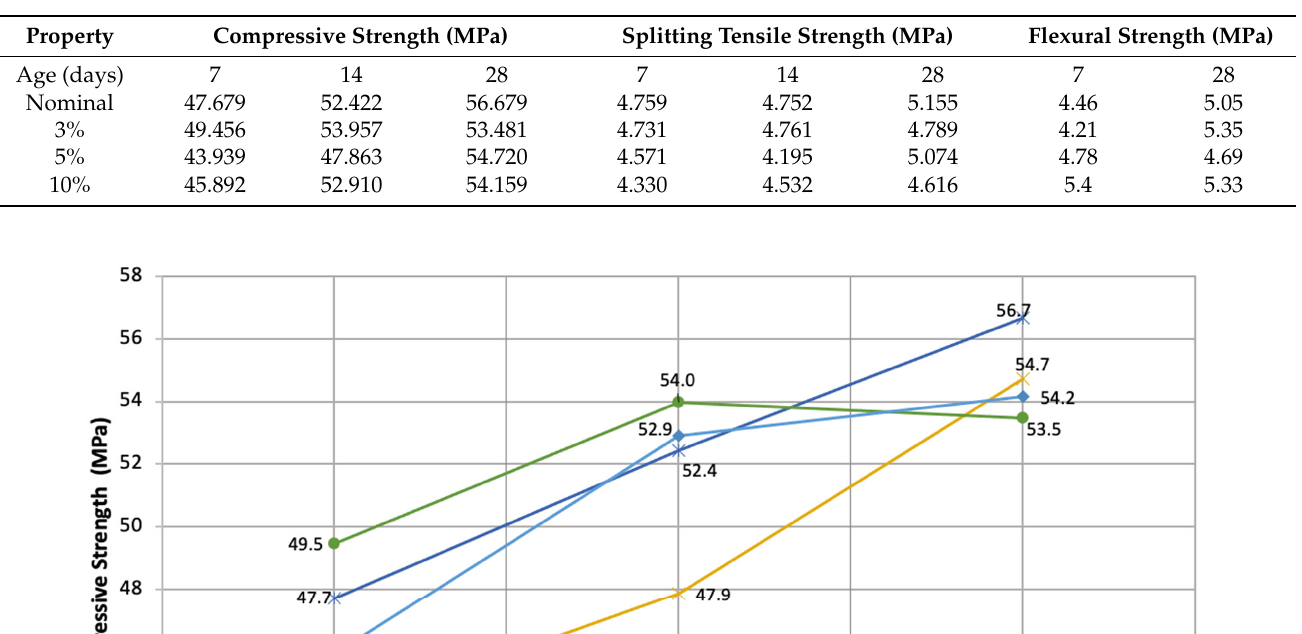
Table 4. Mechanical properties through destructive testing.